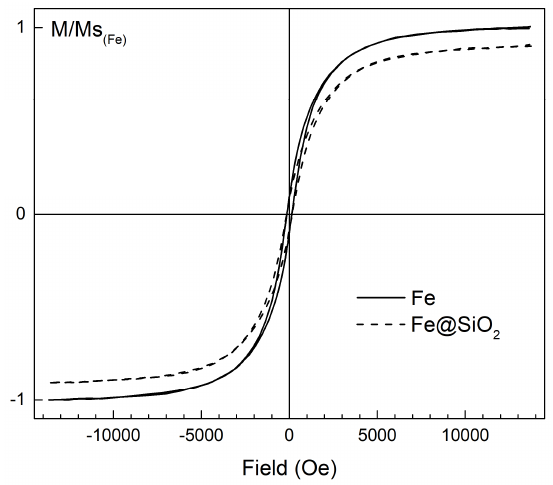
Figure 6. Normalized hysteresis loops measured from the “Fe” and “Fe@SiO 2 ” cold-pressed samples.